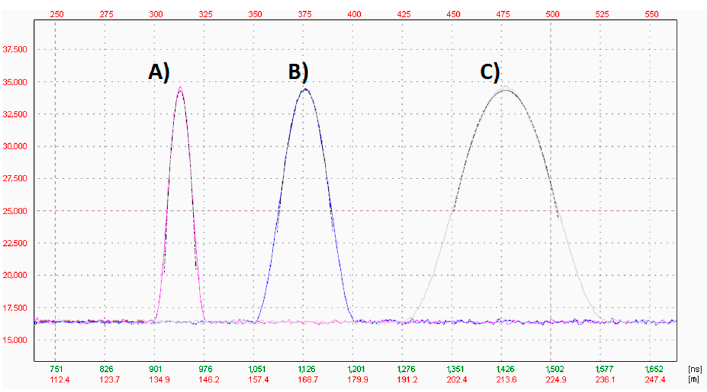
Figure 5. Plots of signals generated for: (A) trial 1, (B) trial 2, (C) trial 3 (see Table 1 for details). The results of simulation trials are presented in Table 2. Table 2. Standard deviations of five trials with N = 1000 measurements each. σ s is calculated from gathered data; u s is calculated using formula (17).